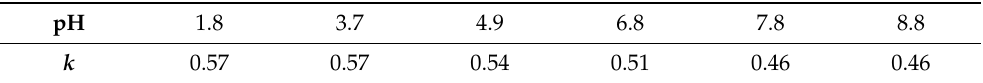
Table 4. Proportionality coefficient k in equation (4) as a function of solution pH.